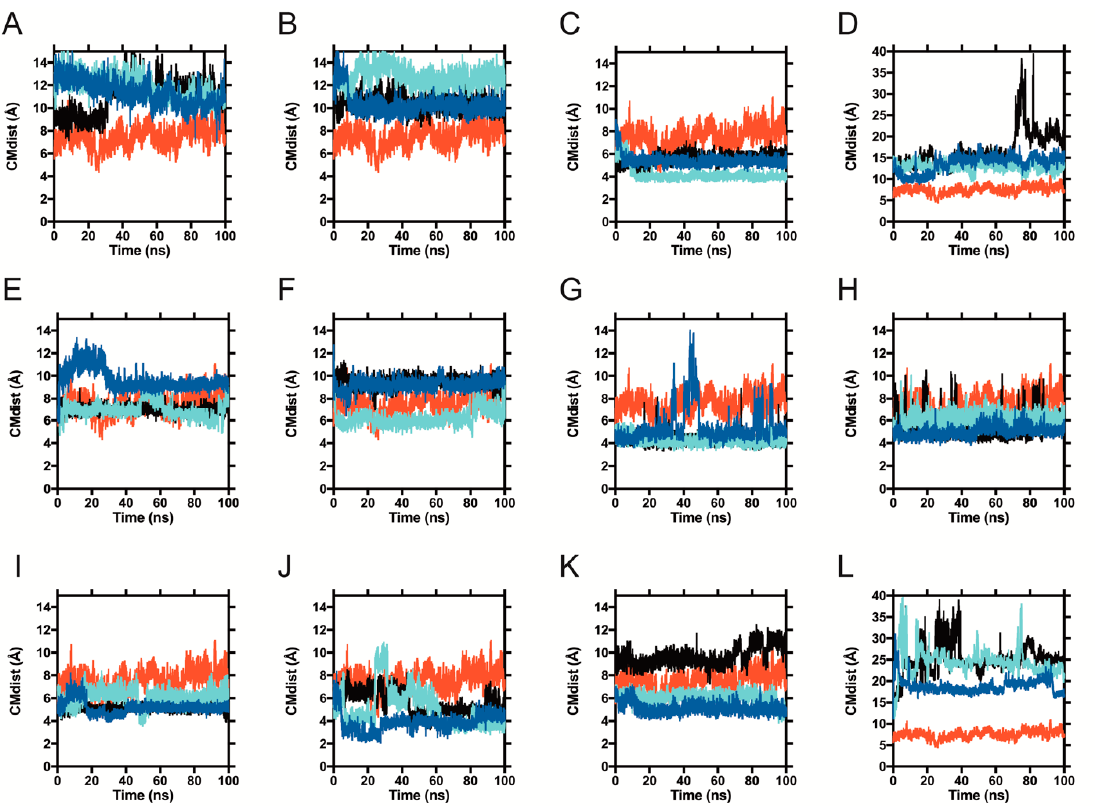
Figure 4. Pesticide position relative to BLG residue F105 during dynamic simulations. The center of mass distance (CMdist) in each of the three molecular dynamics trajectories ran per pesticide is shown throughout time (in light blue, dark blue and black), for representative pesticides: ( A ) Bromadiolone, ( B ) Chlorophacinone, ( C ) Cypermethrin, ( D ) Coumatetralyl, ( E ) Permethrin, ( F ) Rotenone, ( G ) Biphenyl, ( H ) Cyclohexylbenzene, ( I ) Resmethrin, ( J ) Tetramethrin, ( K ) Fenoxycarb and ( L ) Paraquat (same order as in Table 1 and adding paraquat). Palmitate is included in all panels, in red. The scale is the same in all graphs except for ( D ) Coumatetralyl and ( L ) Paraquat, where larger CMdists were observed. Table 2. Analysis of the CMdist frequency histograms for the simulated complexes of 1GXA-pesticide. Simulated Class Number of Histogram Ligands